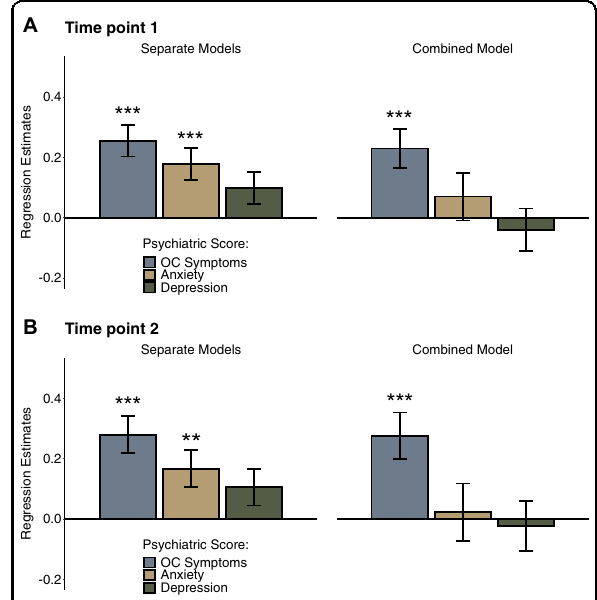
Fig. 4 Regression analysis showing the association between Covid-19 related information seekingand psychiatric scores (OC symptoms, anxiety, and depression). ( A , B ) Regression models estimated separately for each psychiatric dimension (left panels) showed that OC symptoms and anxiety were associated with increased information seeking at time point T1 ( N = 406; A ) and time point T2 ( N = 296; B ). When combining all three psychiatric scores in one model (right panels) only OC symptoms remained associated with information seeking at both time points. Error bars represent standard errors and ** p < 0.01, *** p <